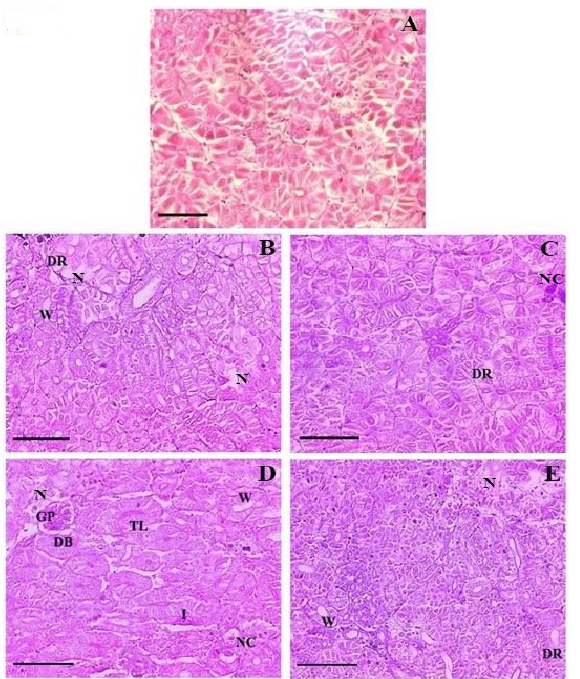
* Qualitative assessment ordinal scale: 0 = no change; 1 = normal with <5% of tissues affected; 2 = mild with 5–15% of tissues affected; 3 = moderate with 15–25% of tissues affected; 4 = marked with 25–50% of tissues affected and 5 = severe with >50% of tissues affected. The qualitative assessment was based on six observations (mean ± standard deviation) for each organ of the respective group. No changes were noted in the control group. FD: florfenicol dosing; PFD: post-florfenicol dosing. 1, 2: values sharing common numeral superscripts in a particular row for a particular treatment differed insignificantly ( p > 0.05). a, b: values sharing common alphabetical superscripts in a particular row for a particular day differed insignificantly ( p > 0.05).